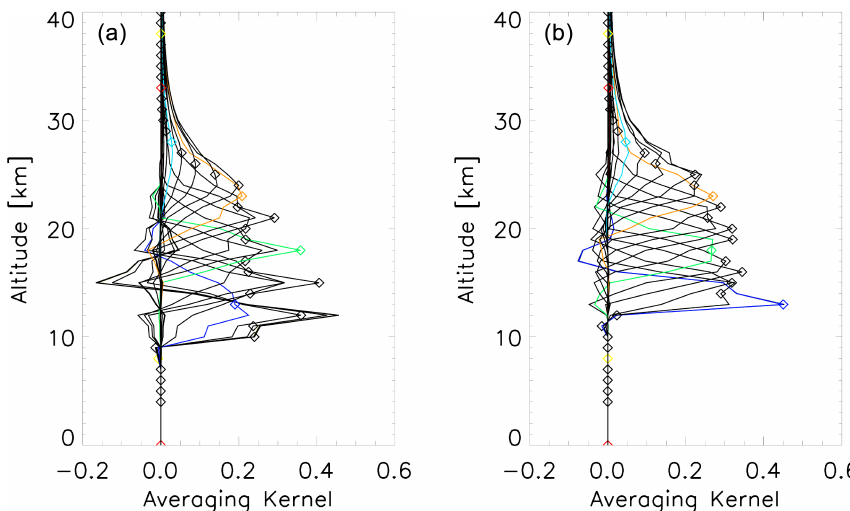
Figure 9. Rows of exemplary averaging kernels of MIPAS CCl 4 . (a) FR period (September 2003). (b) RR period (July 2008).